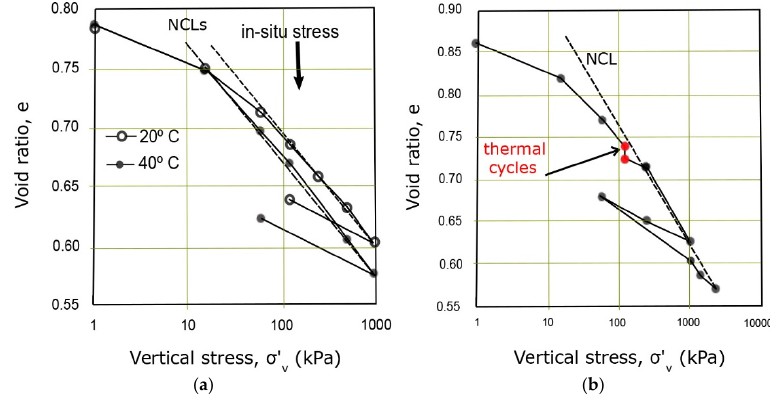
Figure 28. Oedometric results ( a ) tests at 20 ° C and 40 ° C samples; ( b ) test results with thermal cycles (adapted from Reference [204]).